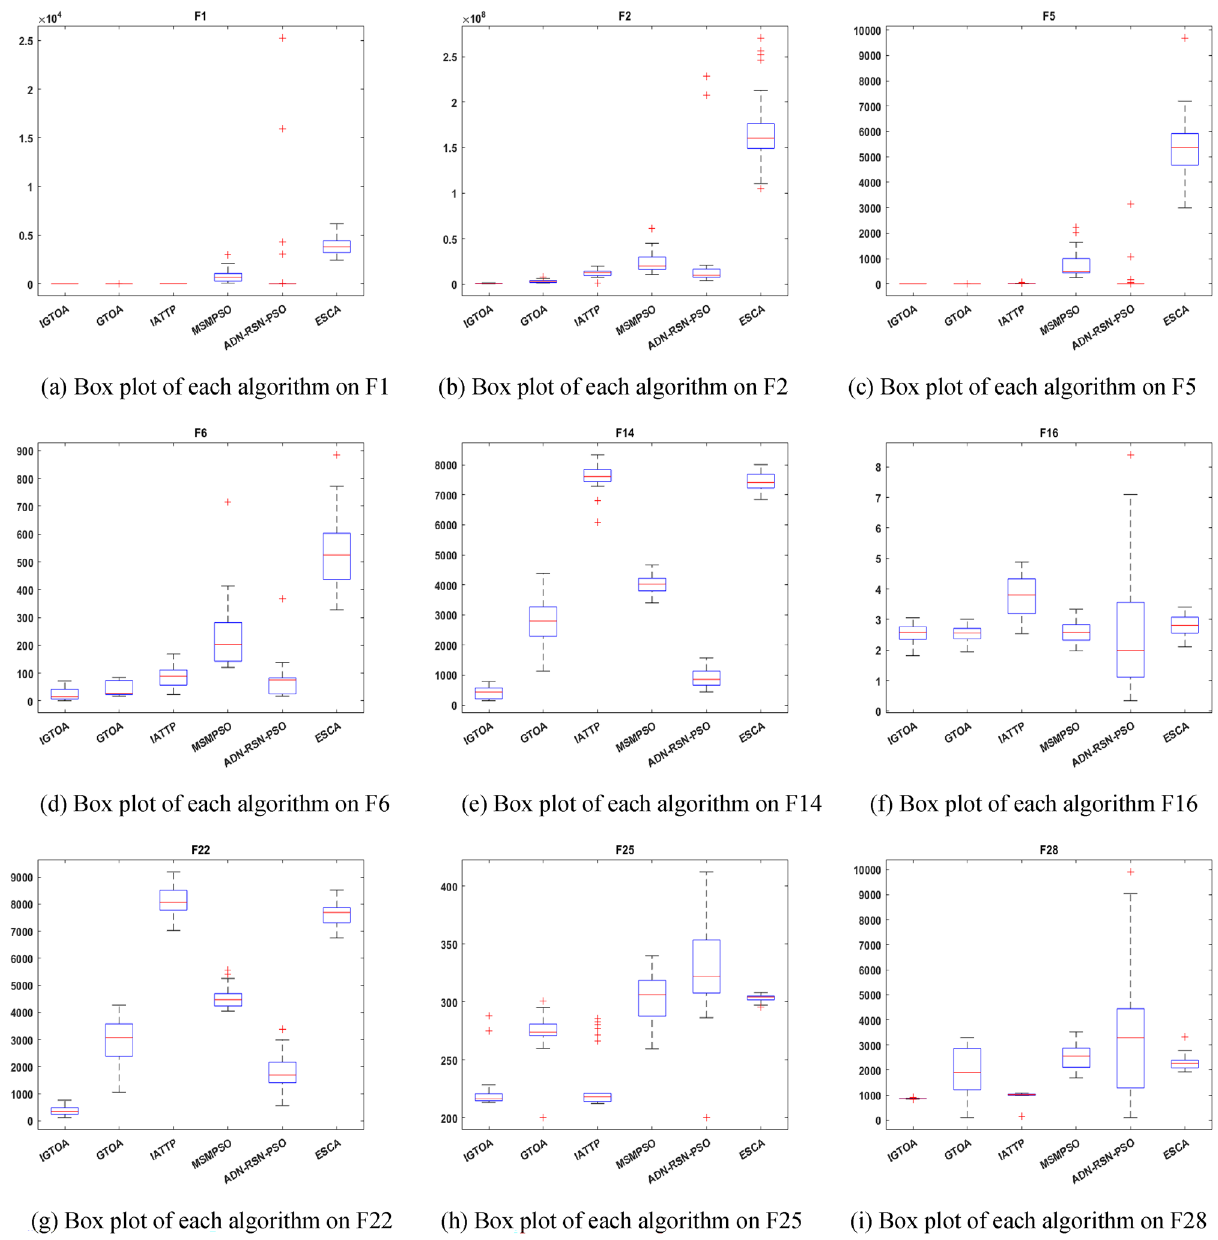
Figure 9. Box plots of the 6 algorithms on the test